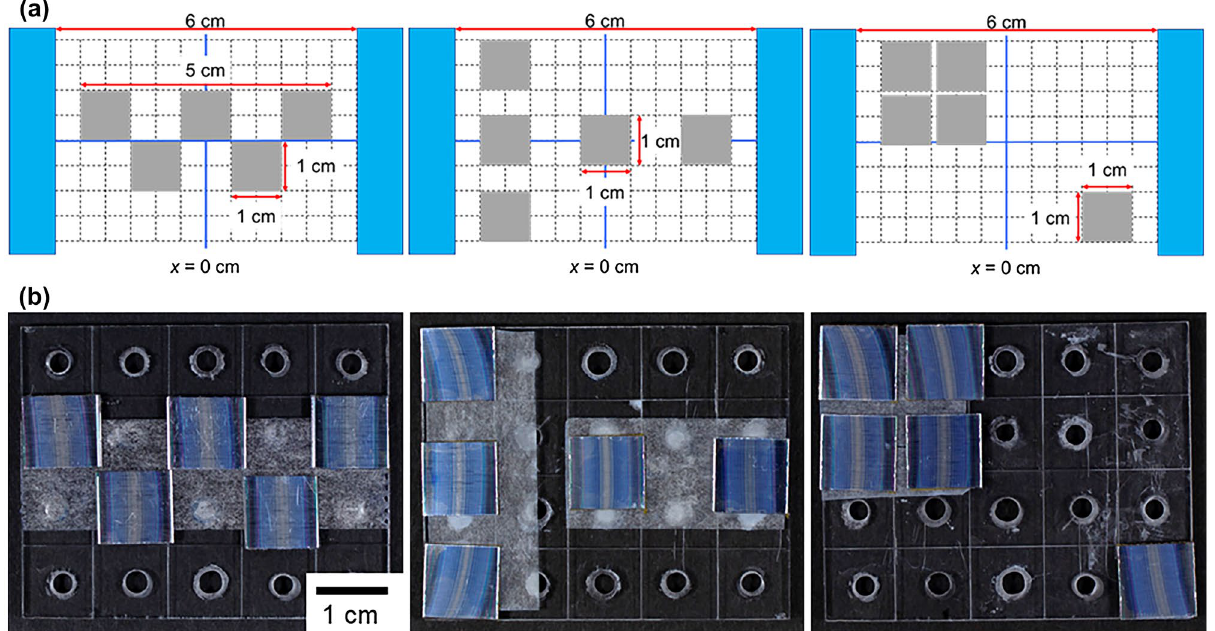
Figure 4. (a) Top-view schematic for bipolar anodization of multiple BPEs and (b) digital photographs of aluminum BPEs recorded after AC bipolar anodization in 10 mmol dm −3 oxalic acid at 20 °C for 60 min at 60 V and subsequent dyeing. The actual BPE positions correspond to those shown in (a)